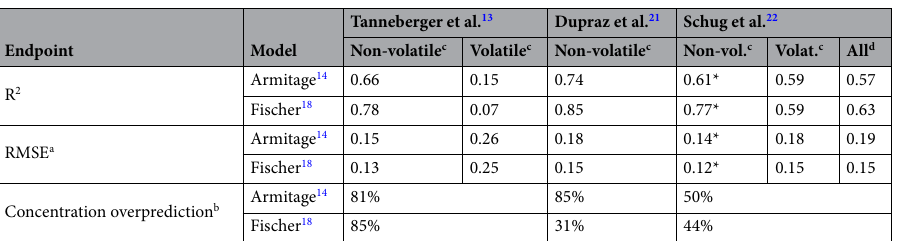
model simulations, a higher (propiconazole) or a lower (3–4-dichloroaniline) concentration was measured after 24 h than it would be expected based on the modelling approach (i.e. outside of the prediction bounds). For the final model calibration, all the data used in the cross-validation test were employed. The results of the final model calibration are presented in Fig. S5. The R 2 and RMSE values are very similar to those obtained during the cross-validation test. The fitted parameters (Table S6) are not significantly different (95% CI overlap) from those obtained by using only the calibration data (Table S5, Fig. 3A); however, the 95% CI are now nar- rower. Such obtained final version of the model was then used to extrapolate to other experimental systems as described in “Materials and methods”, “Model extrapolation to other experimental set-ups”. Extrapolation of the model for adhesive foil to other plates and biological entities. In order to extrapolate the model to other small-scale systems, the composition of the well plate formats (i.e. plastic surface, medium and headspace volumes and the biological material content) had to be determined. The chemical par- titioning between different compartments of the well were obtained from the Fischer’s partitioning to plastic 18 , our previous work 20 and this study (see e.g., Figs. S2 and S3), and were included in the model extrapolation (Table S4). First, the model was extrapolated to 6-well plates with RTgill-W1 cell line monolayer (Fig. 5A). Here, all the chemical concentrations were predicted within 95% prediction bounds even though the experimental